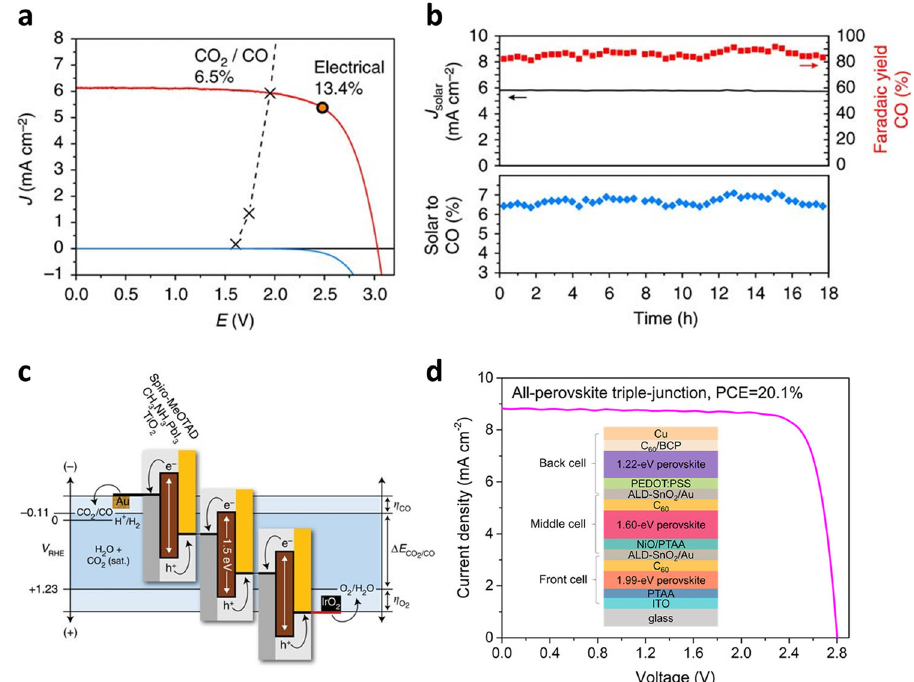
Fig. 12 Perovskite solar cell driven CO 2 reduction. a J – V curves of three series-connected PSCs, overlaid with the matched J – V characteristics of the CO 2 RR and oxygen-evolution electrodes. b Current density, CO% and STC ef fi ciency of the integrated system during a stability test without any external bias under constant illumination for 18 h. c Schematic diagram of the CO 2 RR system powered by CH 3 NH 3 PbI 3 based PSCs (three cells connected in series). a – c adapted with permission from ref. 166 , Copyright 2015 Springer Nature. d J – V curve of monolithic all-perovskite triple-junction cells with the